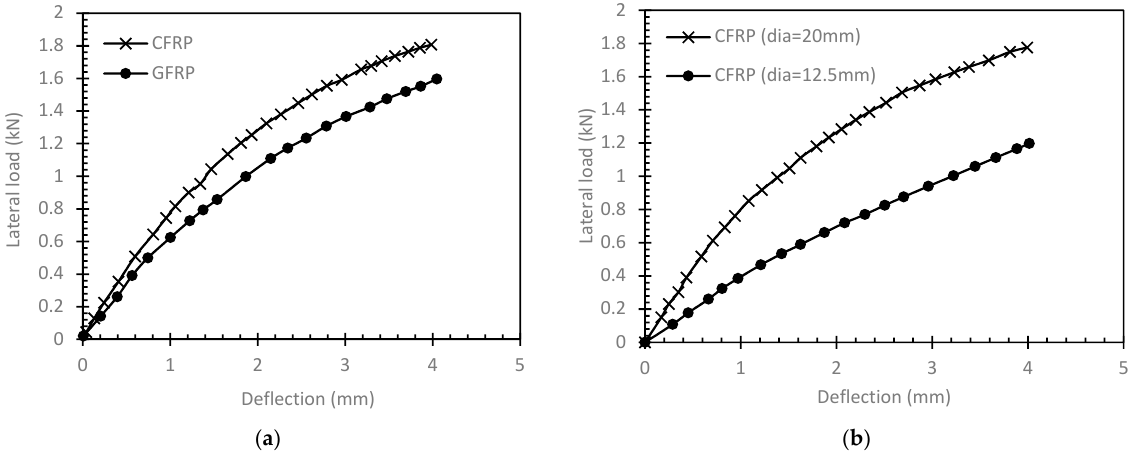
Figure 10. Effect of FRP types under a lateral load ( a ) and effect of diameter under a lateral load ( b ).